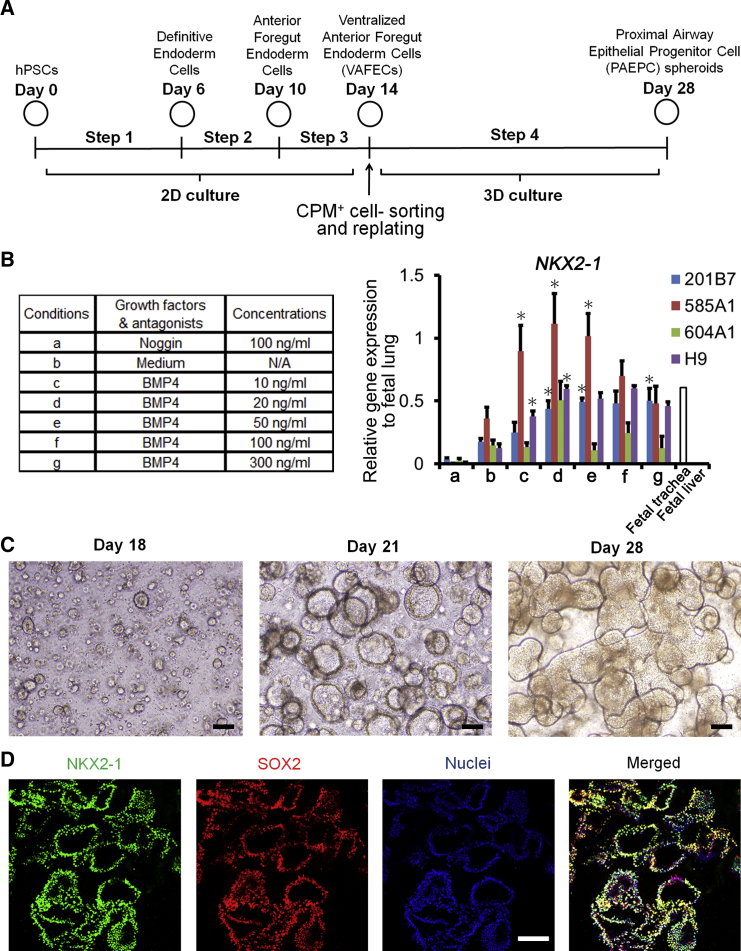
Generation of PAEPC Spheroids from CPM+ VAFECs in 3D Culture(A) Stepwise differentiation to PAEPC spheroids from hPSCs.(B) qRT-PCR of NKX2-1 expression in each hPSC line on day 14, according to the dose of BMP4. The concentrations of BMP4 for each condition in Step 3 are shown in the columns. Each value was normalized to β-ACTIN. The gene expression level of the fetal lungs was set at 1. Error bars represent the mean ± SEM (n = 3 independent experiments). Each condition was compared with condition b for each hPSC line; ∗p < 0.05. N/A, not applicable.(C) CPM+ VAFEC-derived spheroids (201B7 hiPSCs) on days 18, 21, and 28.(D) CIF imaging shows 201B7 hiPSC-derived PAEPC spheroids coexpressing SOX2 and NKX2-1 on day 28.Scale bars, 100 μm. See also Figure S1 and Tables S1 and S2.